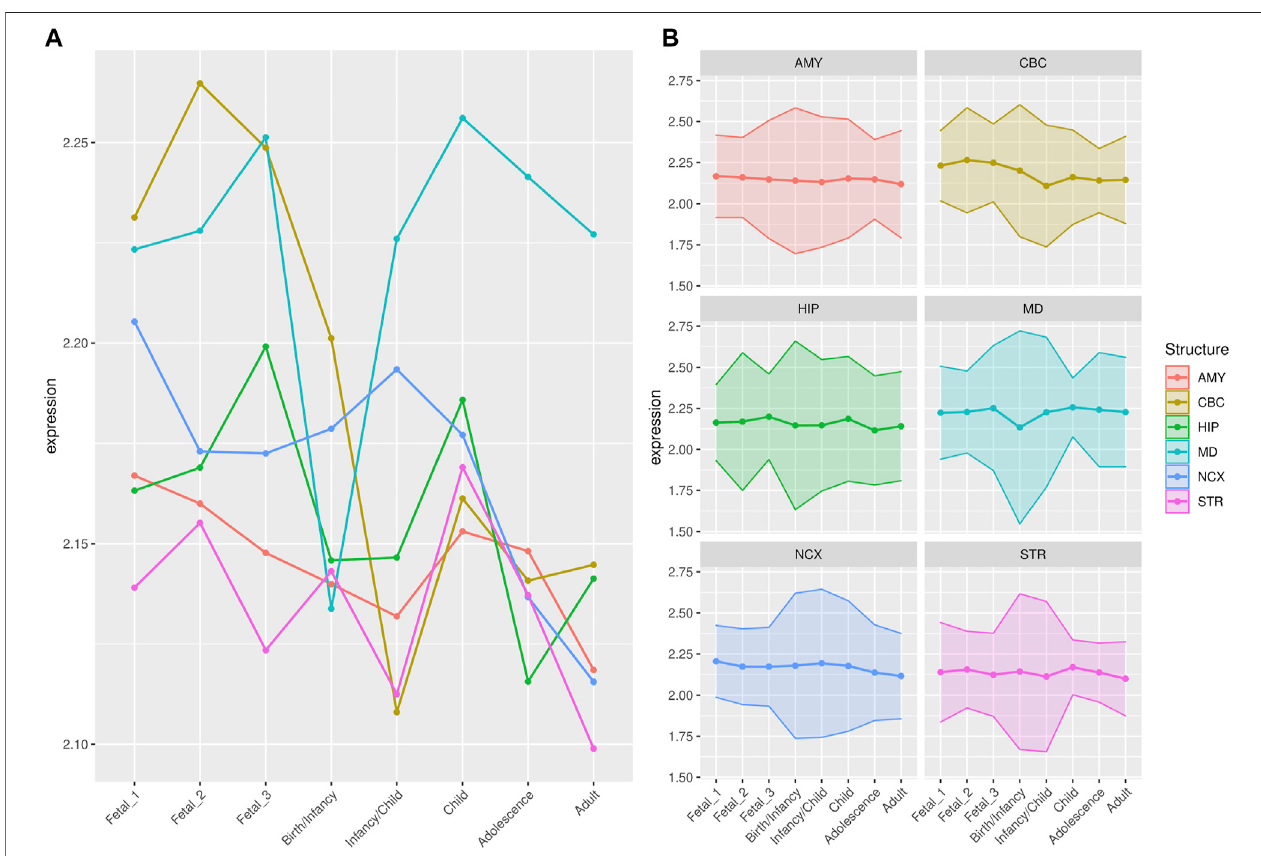
FIGURE2| Medianexpression ofgeneswithinlargedeserts. (A) Comparison ofmedian ofgeneexpression acrossdevelopmentalstagesbetweenstructuresand (B) Standard deviation per structure, for genes ( n = 255) within the four large deserts of introgression. The cerebellar cortex, prenatally, and the mediodorsal nucleus of the thalamus prenatally and postnatally present the highest expression. The median expression pro fi le of genes within deserts, per chromosome, is shown in Supplementary Figure S12 . Structures: AMY, amygdala; CBC, cerebellar cortex; HIP, hippocampus; MD, mediodorsal nucleus of thalamus; NCX, neocortex; STR, striatum. Stages: Fetal 1: 12-13 post conception weeks (PCWs); Fetal 2: 16-18 PCW; Fetal 3: 19-22 PCW; Birth — Infancy: 35-37 PCW and 0 – 0.3 years; Infancy — Child: 0.5 – 2.5 years; Childhood: 2.8 – 10.7 years, Adolescence: 13 – 19 years; Adulthood: 21 – 64 years [as in (Li et al., 2018)].